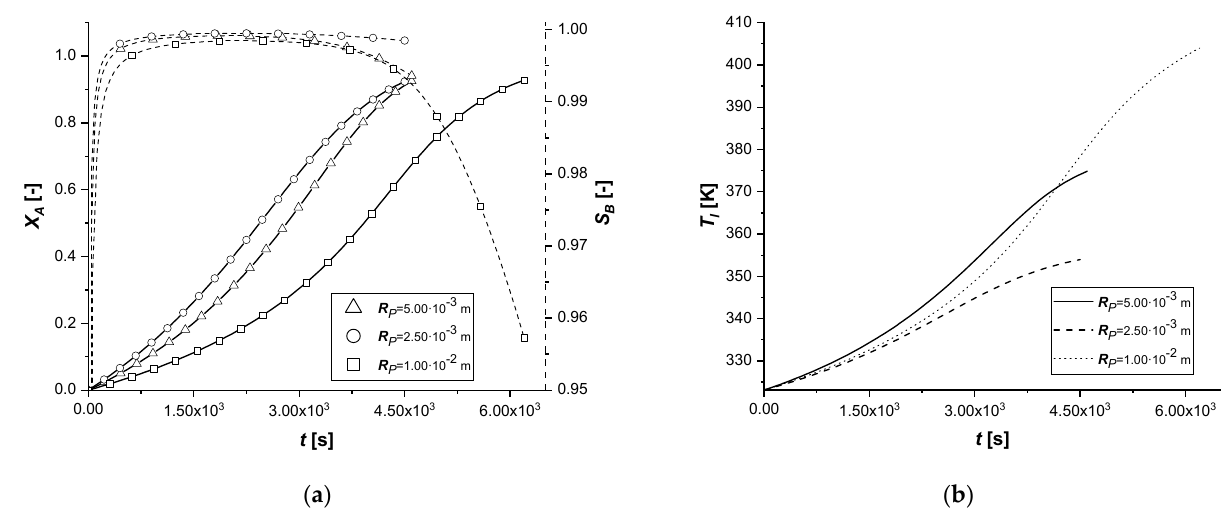
Figure 20. ES R P investigation. ( a ) Bulk profiles over time of X A and S B . ( b ) Bulk profile of T l over time.